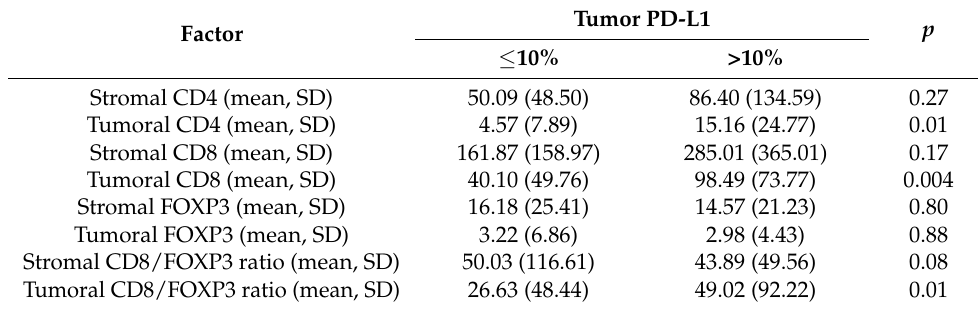
Table 3. Association between CD4 + , CD8 + and FOXP3 + TILs and PD-L1 expression (clone 22C3) in the cohort of 125 OSCC